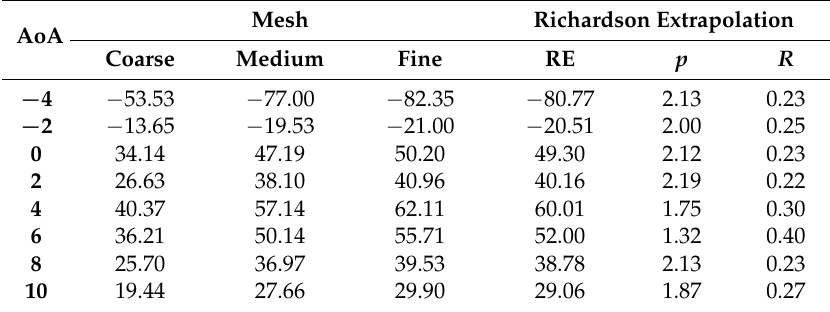
Table 2. Results of the mesh independency study. AoA: angle of attack.